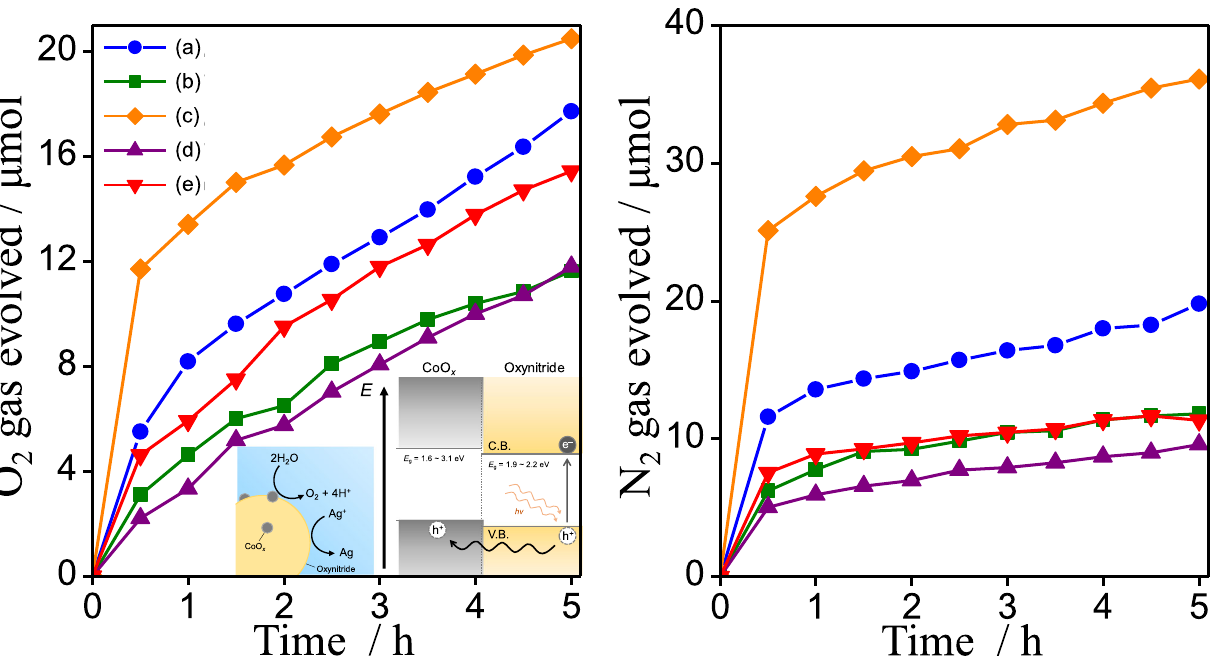
Fig. 6 O 2 and N 2 evolution of CoO x -loaded Sr 1 - x Ba x W 1 - y Ta y (- O,N)